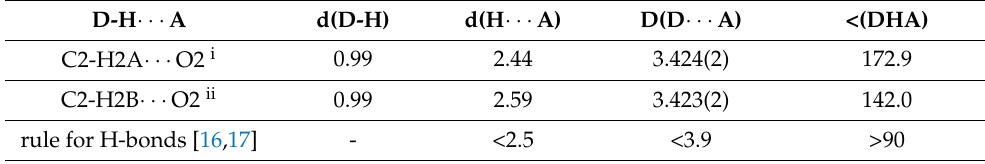
Figure 3. Crystal structure of γ -lac, view along the b-axis, C-H···O hydrogen bonds marked with black dashed lines. Table 2. Distance/Å and angles/° of the hydrogen bonds in γ - lac .